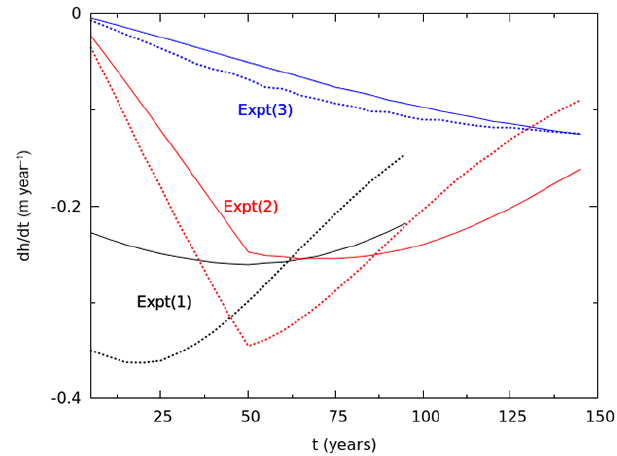
Figure 2. Evolution of thinning rates after ELA perturbations are applied to a model debris-covered glacier (solid line) and a debris- free glacier (dotted line). The warming rate profiles for each of the experiments are described in Sect.